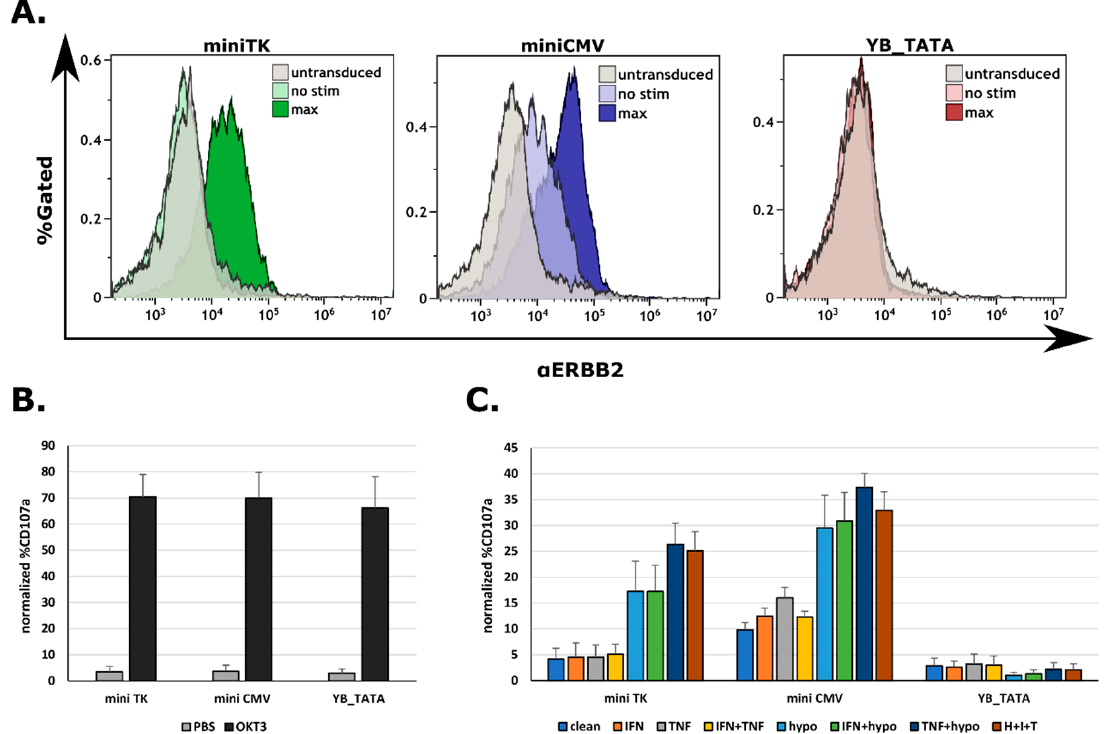
Figure 5. Degranulation against CAR cognate antigen shows a threshold behavior as a function of promoter strength: At 72 h following infection, the human primary T-cells were treated for 48 h with the indicated cytokines (250 U/mL for each cytokine) and for 18 h under hypoxic conditions. Cells were then incubated for 4 h with PBS, anti CD3 OKT3 or ERBB2-FC recombinant protein coated wells. Cells were than washed and stained using CD107a APC or a recombinant ERBB2-Fc. ( A ) Representative FACS plots showing membranal CAR expression by the indicated promoter in the non-stimulated and fully stimulated condition. ( B ) Maximum and background degranulation of human primary T-cells transduced with the indicated promoter controlling the expression of the Herceptin based CAR, showing only the Zs + fraction. ( C ) Average from triplicates of the CD107a + cells from the ZsGreen positive fraction, normalized to the total %ZsGreen positive cells in the indicated treatment and specific promoter.